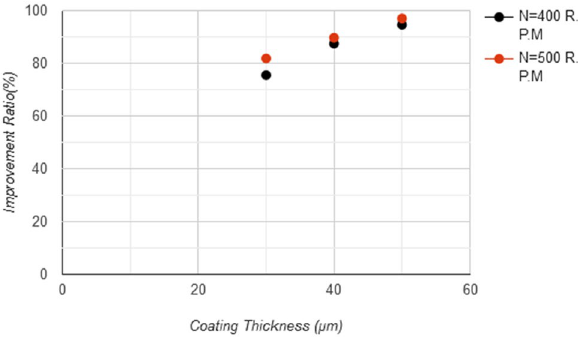
Figure 15. Coating layer thickness with improvement ratio in wear resistance test (pin on